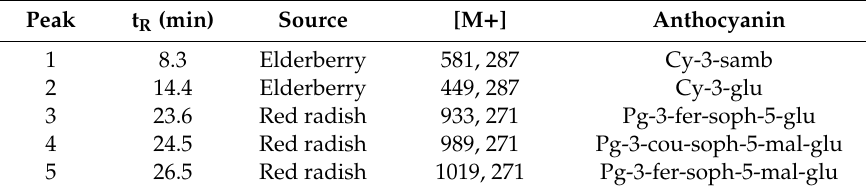
Table 1. Identities of anthocyanins from elderberry and red radish identified in skin samples after topical application by HPLC-PDA-MS. Numbers correspond to peaks found in Figure 1. Peak t R (min) Source [M + ] Anthocyanin